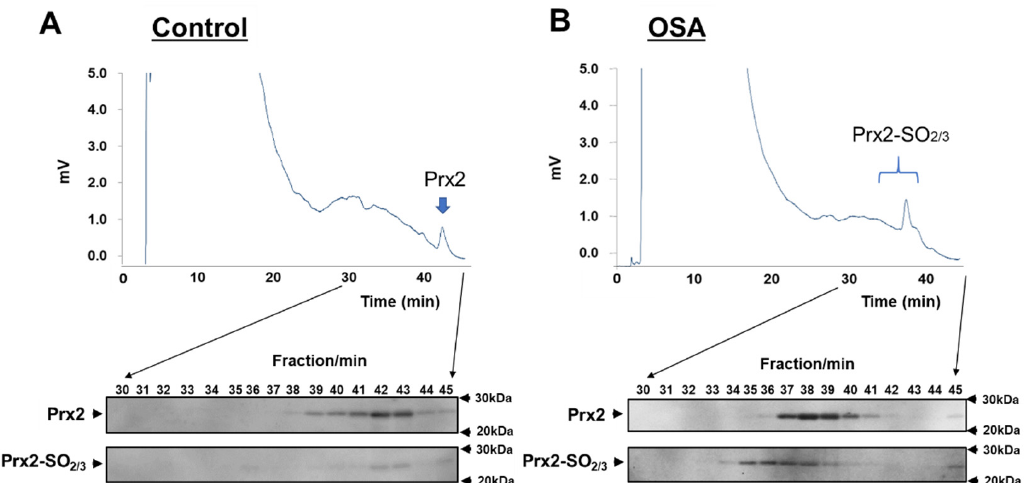
Figure 4. Chromatographic analysis of Prx2 oxidation in RBC lysates from a healthy subject and a patient with OSA. The samples were prepared as described in the Materials and Methods section. Each representative result from the OSA patient group ( n = 3) and control group ( n = 3), respectively, was shown. Chromatograms of RBC lysates from a healthy control ( A ) and a patient with OSA ( B ). Proteins in the 16 fractions (29–45 min) were collected and concentrated. Each dried sample was resolved in SDS buffer and subjected to 5–20% SDS-PAGE, followed by Western blotting with anti-Prx2 antibody (upper image). The same PVDF membranes were stripped and re-probed with anti-Prx2-SO 2/3 antibody (lower image).